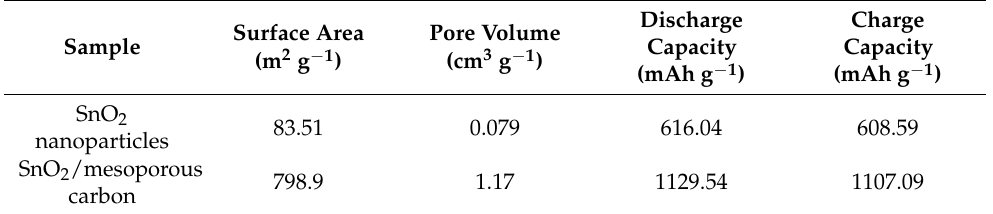
Table 4. Characteristics and electrochemical properties of SnO 2 nanoparticles and SnO 2 /mesoporous carbon composite.